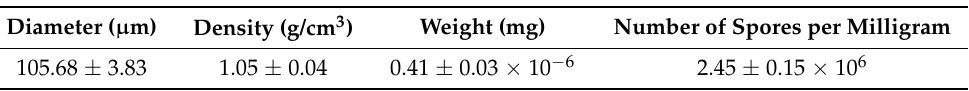
Figure 1. SEM image of spores of Ceratopteris thalictroides . Table 1. Diameter, density, and weight of Ceratopteris thalictroides . Data represent the mean ± SD ( n =